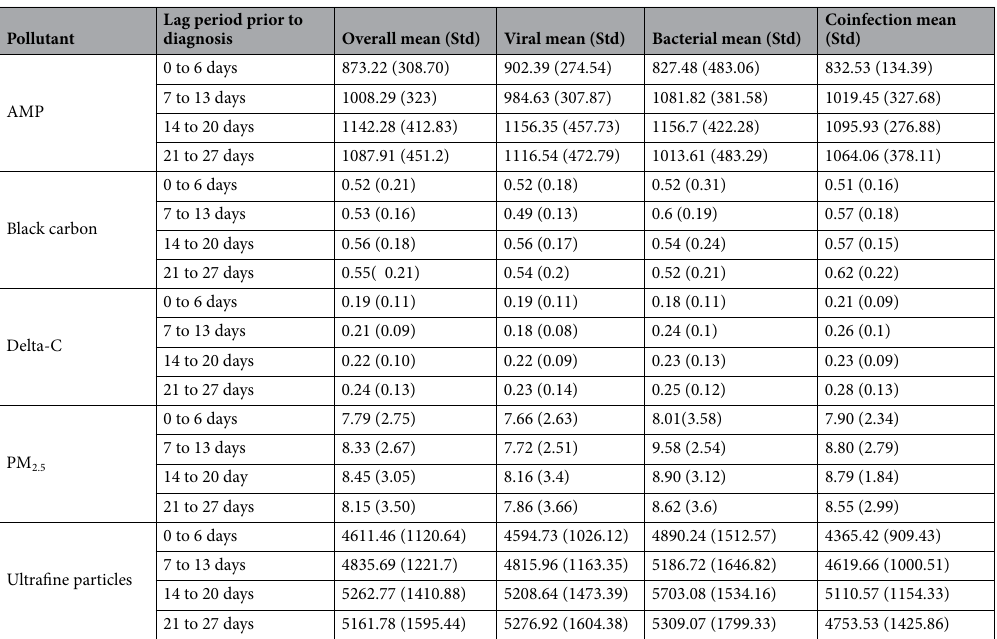
Table 2. Ambient air pollution concentrations for all participants, at multiple lag times, stratified by infection